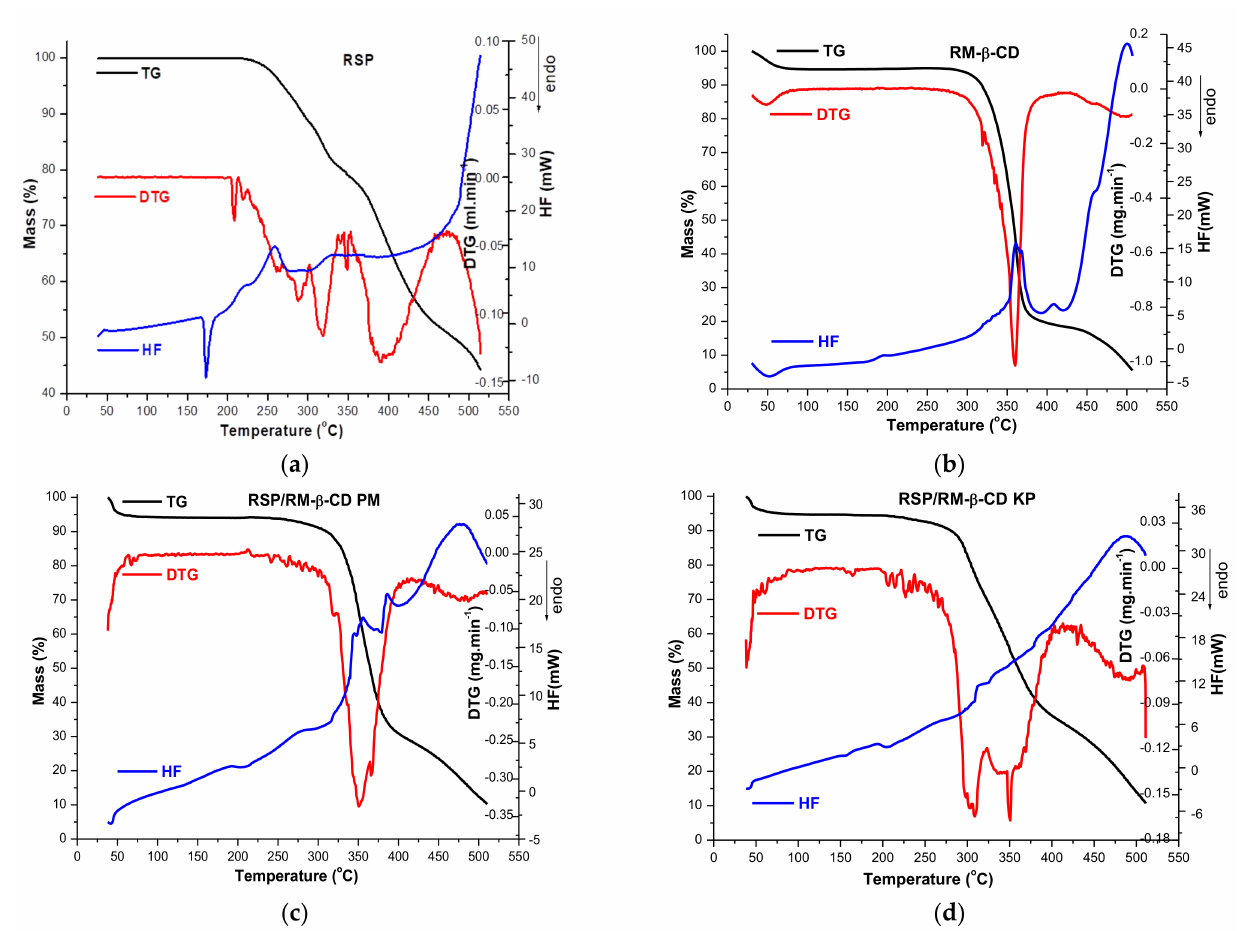
Figure 4. The thermal profile (TG-thermogravimetry/DTG-derivative thermogravimetry/HF-heat flow) of: RSP ( a ); RM- β - CD ( b ); RSP/RM- β -CD physical mixture ( c ); and kneaded product ( d ) in air atmosphere (100 mL/min), temperature range of 40–500 ◦ C and heating rate of 10 ◦